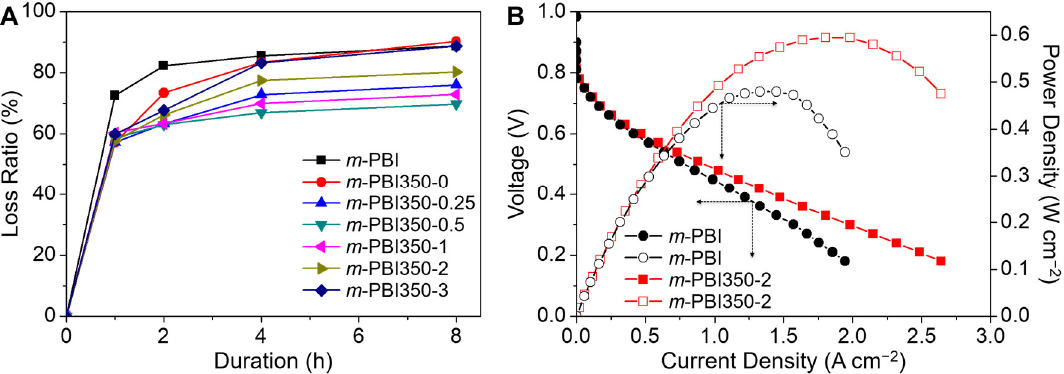
Figure 6. ( A ) Phosphoric acid retention of the membranes with respect to time. ( B ) Fuel cell performances in terms of power density and voltage with respect to the current density of m -PBI and m -PBI350-2.